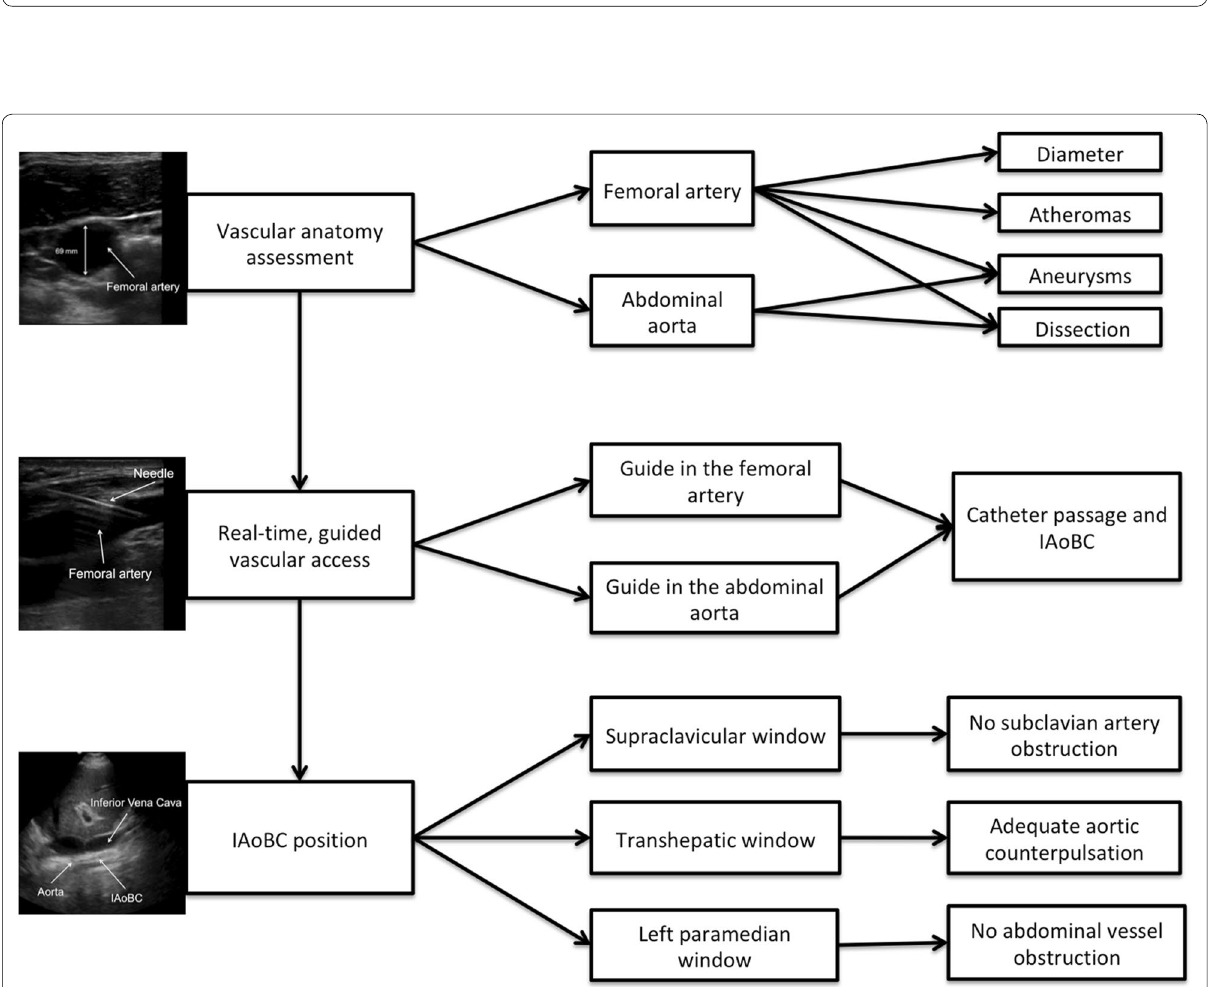
Fig. 7 Proposed technique for ultrasound-guided intra-aortic balloon counterpulsation